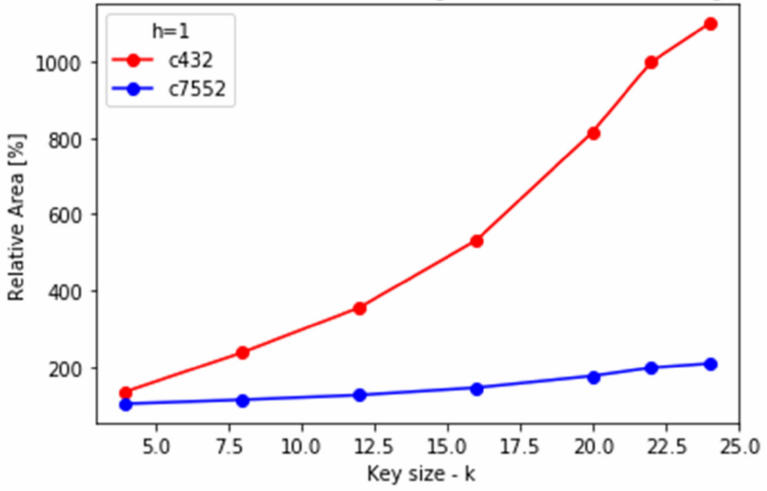
Figure 23. Relative area increase of locked netlists for different values of key